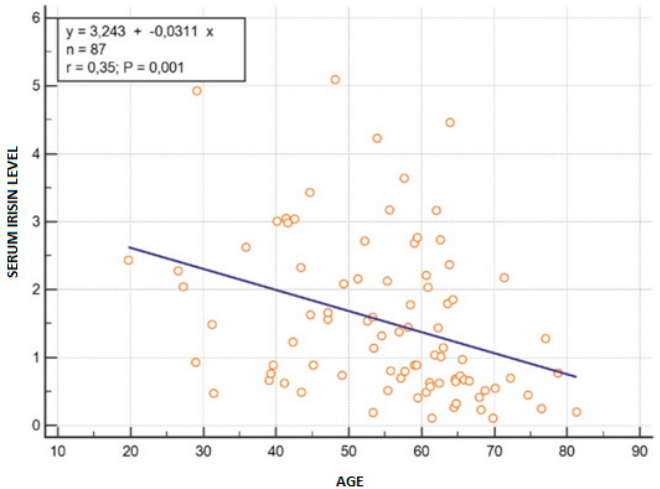
Figure 1. Correlation between serum irisin and patients’ age. Table 9. Correlation between serum irisin with some analyzed parameters.